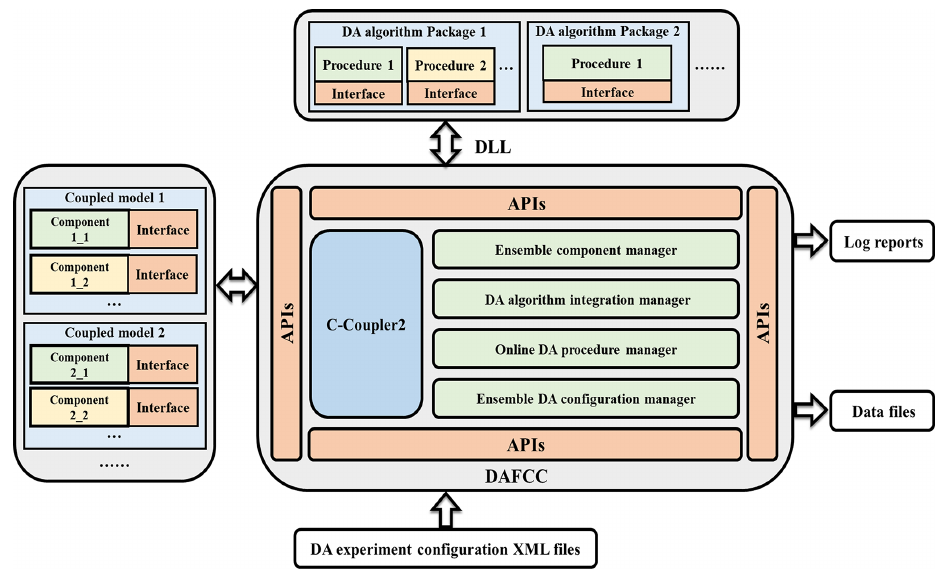
Figure 2. Architecture of